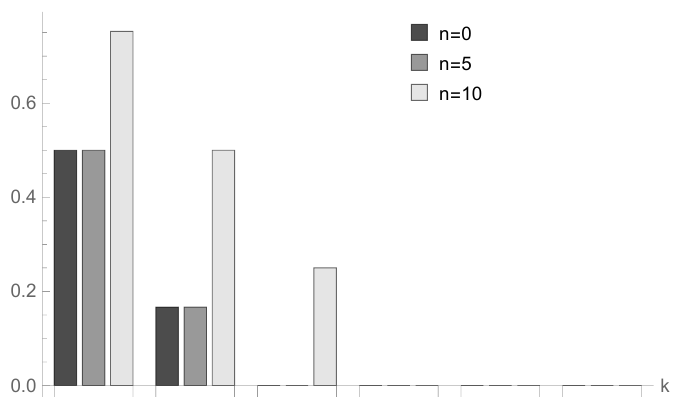
Figure 4. Conditional probabilities (cid:98) ∆ n ( k ) for geometric processing distribution, (cid:36) = 0.75 and n = 0, 5 and 10.